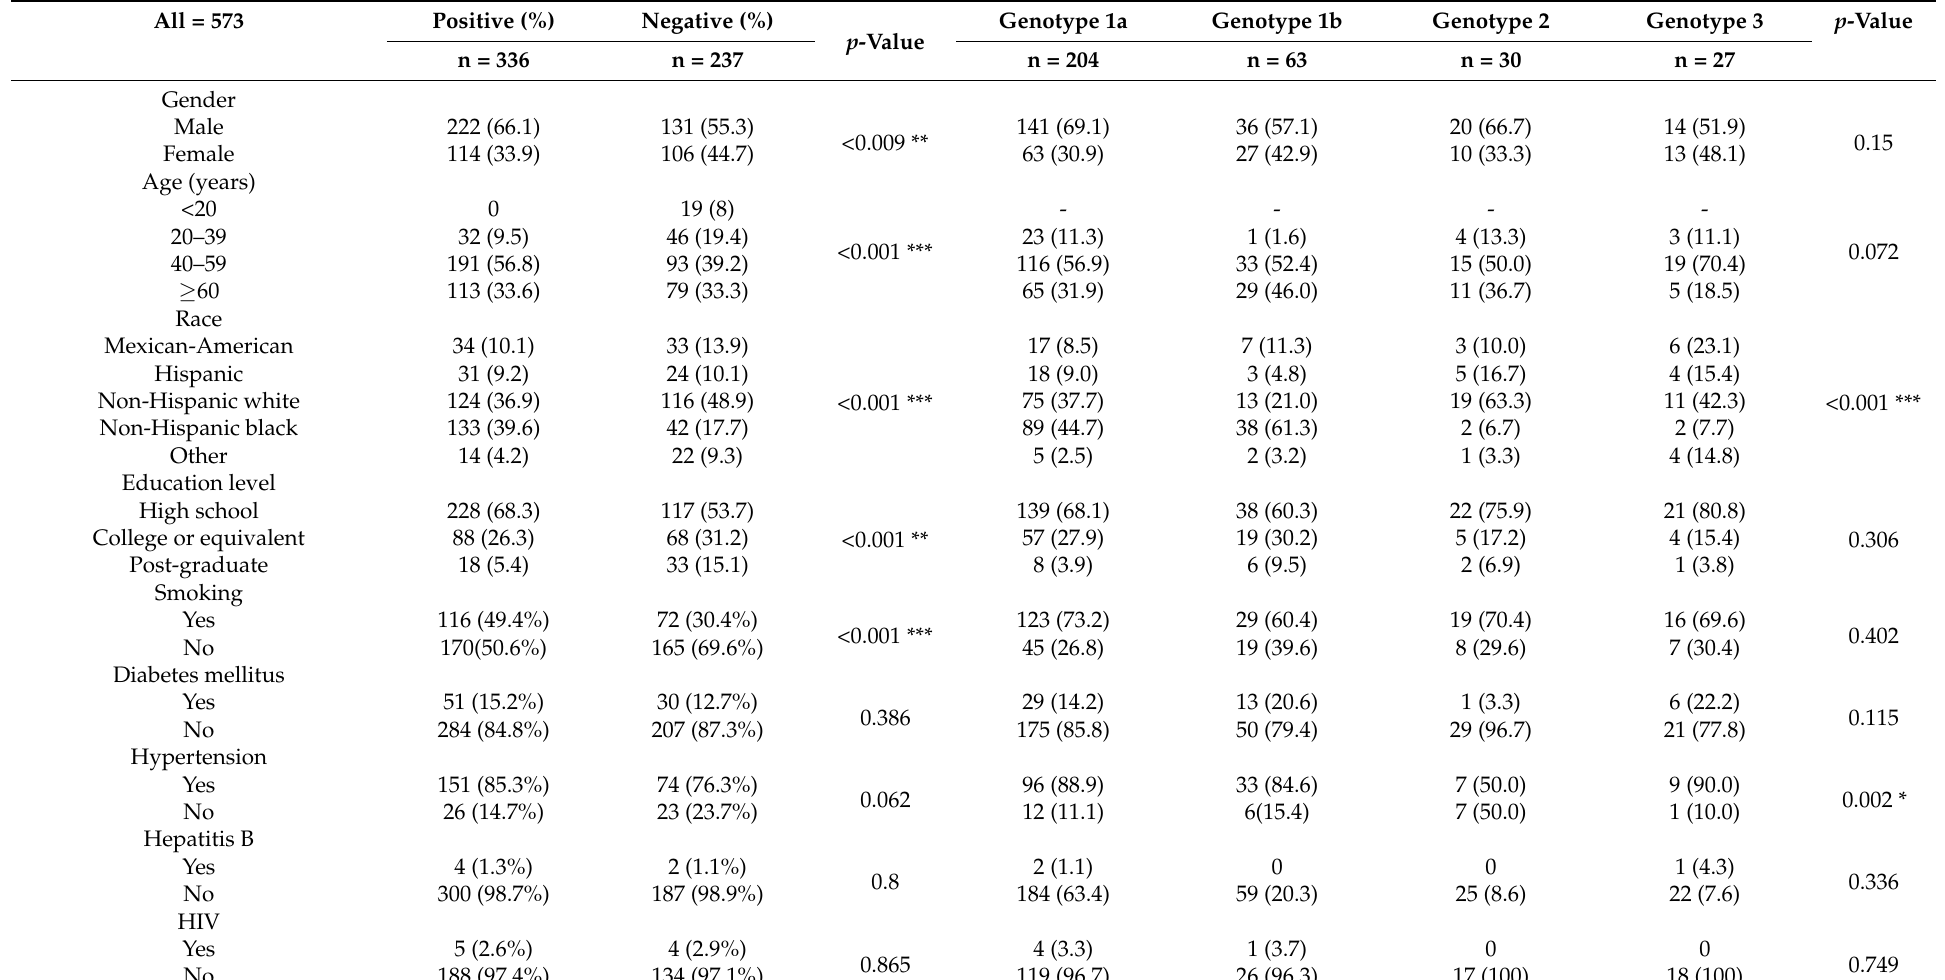
Table 1. Socio-demographic variables and distribution of HCV